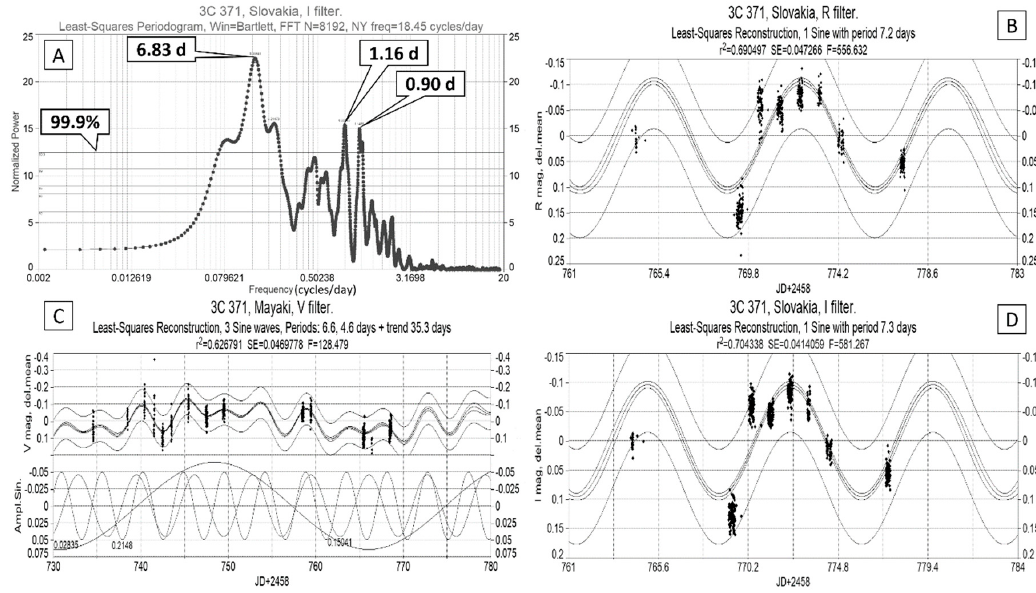
Figure 11. ( A ) shows an example of periodogram for observations at the Vihorlat observatory (I). It can be seen that the main maxima exceed the 99.9% confidence level (which means that only 1 from 1000 sets of noise, can accidentally give a maximum with this height). ( C ) shows an example of a trigonometric polynomial drom 2 sinusoids, plus a trend segment for observations at the Mayaki Observatory (V). ( B , D ) show examples of fitting 1 sinusoid into the data series, R and I, respectively. In this example, the approximation parameters, R 2 = 0.62, SE = 0.047 (standard error of approximation), F -statistics (Fisher) = 128.48 ( С ); R 2 = 0.69, SE = 0.047, F = 556.63 ( В ); R 2 = 0.70, SE = 0.041, F = 581.26 ( D ). This figure shows the values of the periods of the peaks of the Lomb-Scargle periodogram for the filter I data (Vihorlat observatory), as well as three graphs (Mayaki and Vihorlat observatories) with the approximation of the original data by sinusoids. It can be seen, for example, the initial value of the period of 6.83 days (I) was refined to the value of 7.3 days by fitting the sinusoid to the data using the least squares method. This figure also shows the parameters of the approximation (coefficient of determination R 2 , standard error SE и F -Fisher statistics) which shows good reliability of the found periods values. The values of approximation parameters are shown in the caption to Figure 11.